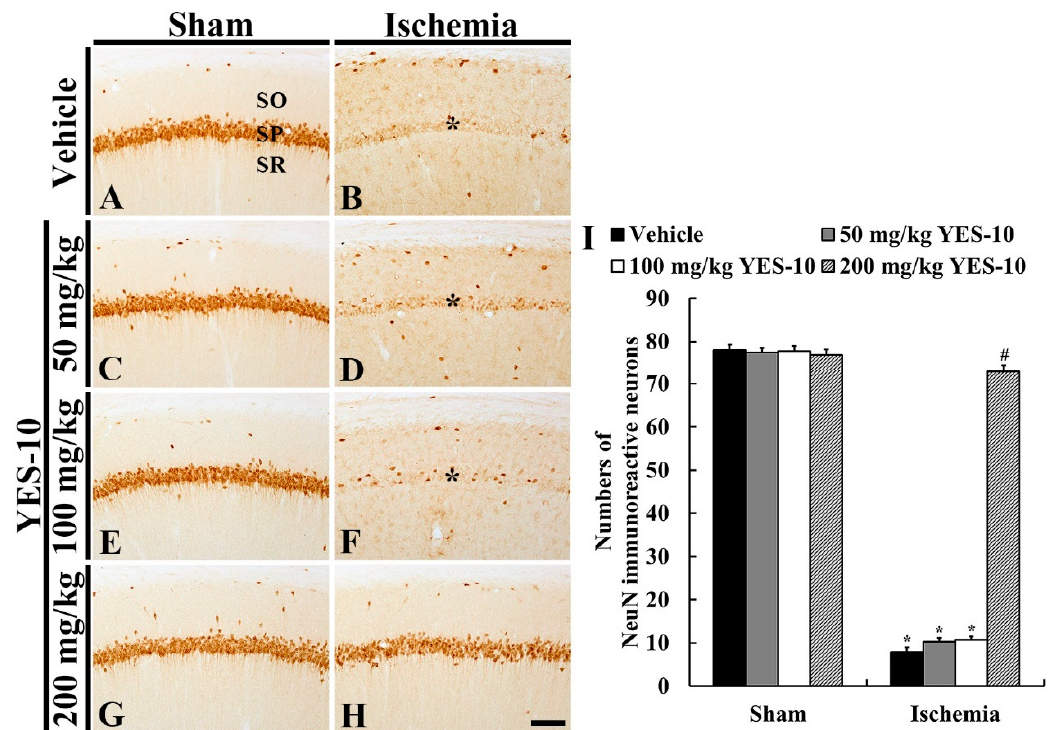
Figure 2. NeuN immunohistochemistry in the CA1 field of the vehicle/sham ( A ), 50 mg/kg YES-10/sham ( C ), 100 mg/kg YES-10/sham ( E ), 200 mg/kg YES-10/sham ( G ), vehicle/ischemia ( B ), 50 mg/kg YES-10/ischemia ( D ), 100 mg/kg YES-10/ischemia ( F ) and 200 mg/kg YES-10/ischemia ( H ) groups at 5 days after ischemia/reperfusion. In all sham groups, pyramidal cells in the CA1 field show strong NeuN immunoreactivity. However, most of CA1 pyramidal cells were hardly NeuN immunoreactivity in the vehicle, 50 and 100 mg/kg YES-10/ischemia groups (asterisks). In the 200 mg/kg YES-10/ischemia group, many CA1 pyramidal cells show strong NeuN immunoreactivity. Scale bar = 100 μ m. ( I ) The mean number of NeuN immunoreactive cells in the CA1 field at 5 days post-ischemia (n = 7 in each group, * P < 0.05 versus vehicle/sham group, # P < 0.05 versus vehicle/ischemia group). The bars indicate the means ± standard error of mean (SEM) standard error mean.